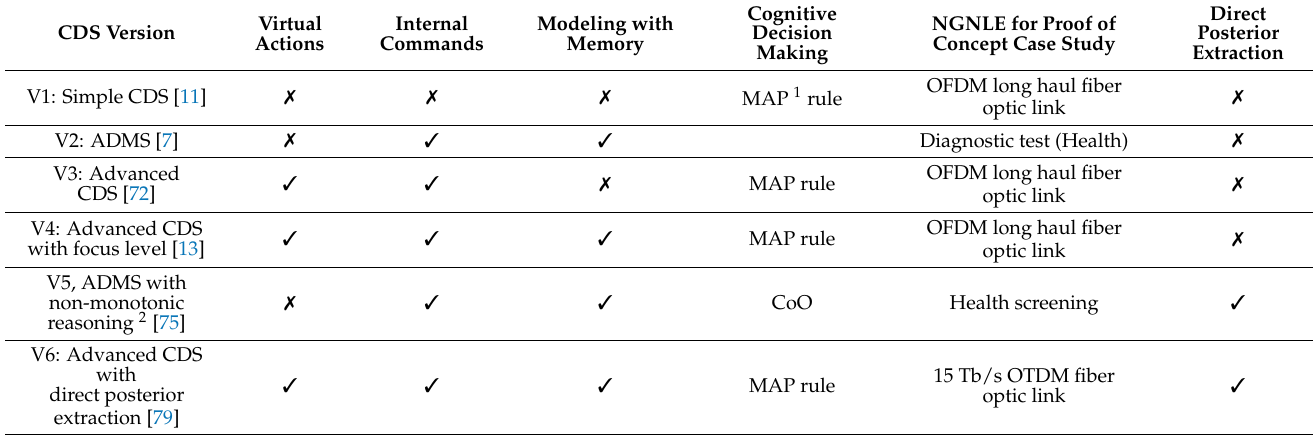
Table 2. Six versions of CDS have